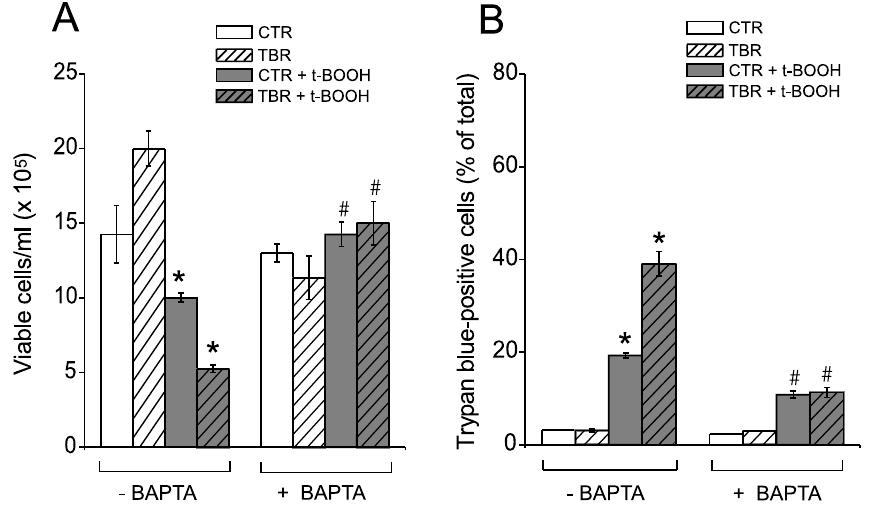
Fig. 5 – t-BOOH-induced death of CTR and TBR lymphocytes is prevented by intracellular Ca 2 + chelation. (A) Growth of BAPTA-loaded CTR (white and gray bars) and TBR lymphocytes (white hatched and gray hatched bars) incubated for 4 h in the absence of 500 µ M t-BOOH (white and white hatched bars) or in its presence (gray and gray hatched bars). (B) Death of BAPTA-loaded CTR and TBR lymphocytes incubated for 4 h in the presence of 500 µ M t-BOOH or in its absence. *p < 0 . 05 vs. respective group without t-BOOH, in the absence of BAPTA. # p < 0 . 05 vs. respective group treated with t-BOOH, in the absence of